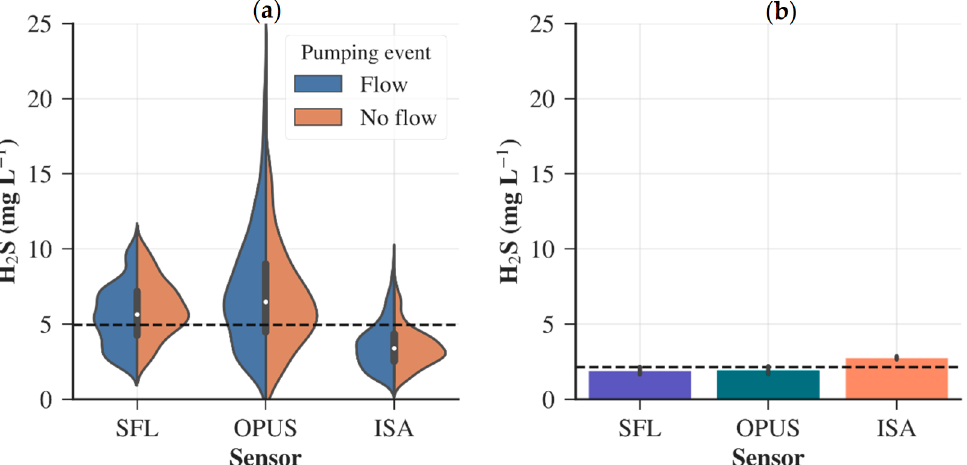
Figure 4. Comparison of the sensors under different flow conditions. Violin plots (combination of boxplots and density trace plots) comparing the median H 2 S concentration measured by the sensors during the switched on ( ) and off ( ) periods of the intermittent scenario ( a ). Barplots comparing the median H 2 S measurements of the sensors during constant flow scenario ( b ). The dashed lines ( --- ) mark the mean H 2 S recorded by the sensors for the different wastewater operation.